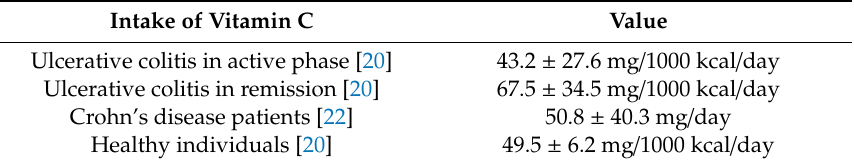
Table 2. Intake of vitamin C among patients su ff ering from IBD and heathy